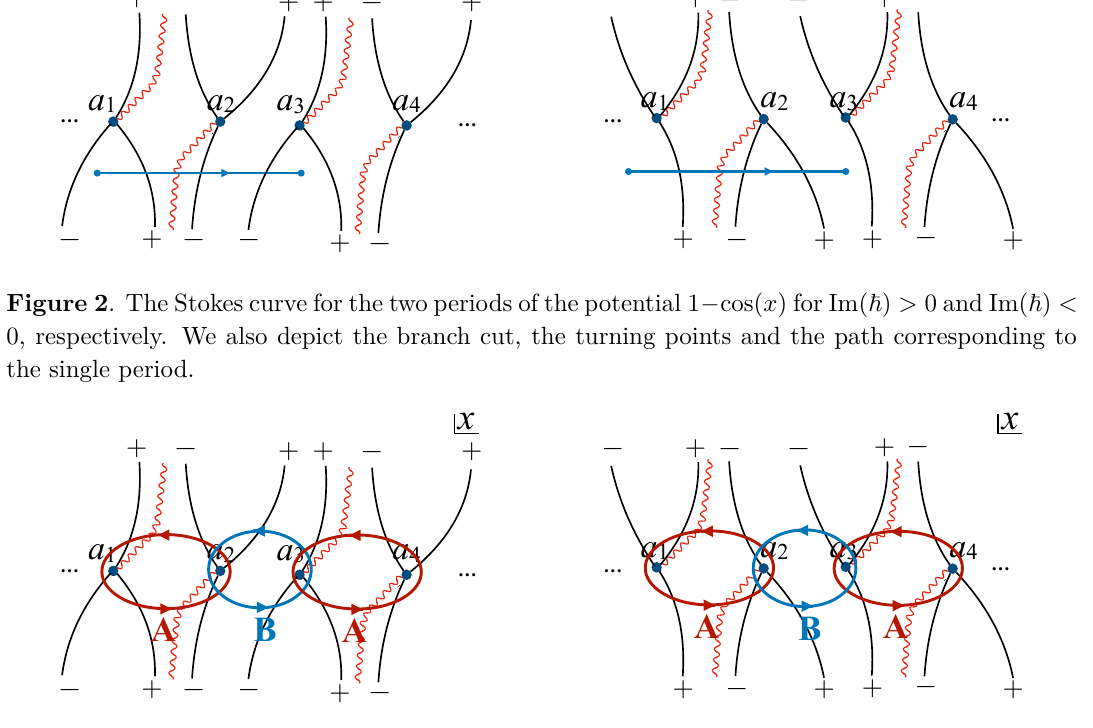
Figure 3 . The Stokes curve for the two periods of the potential 1 − cos( x ) , with the cycles A and B being